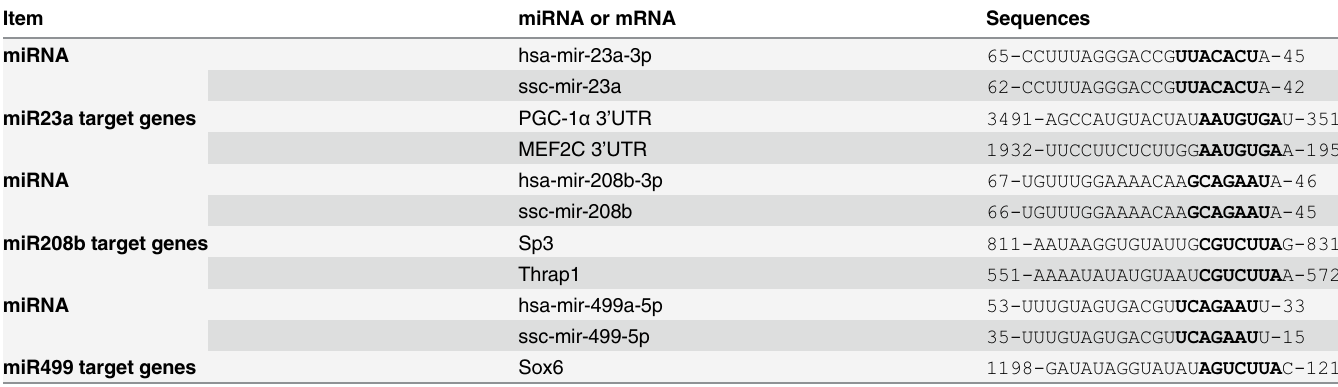
Table 2. The primer sequences of miRNAs and the 3 ’ UTR sequences of target genes.